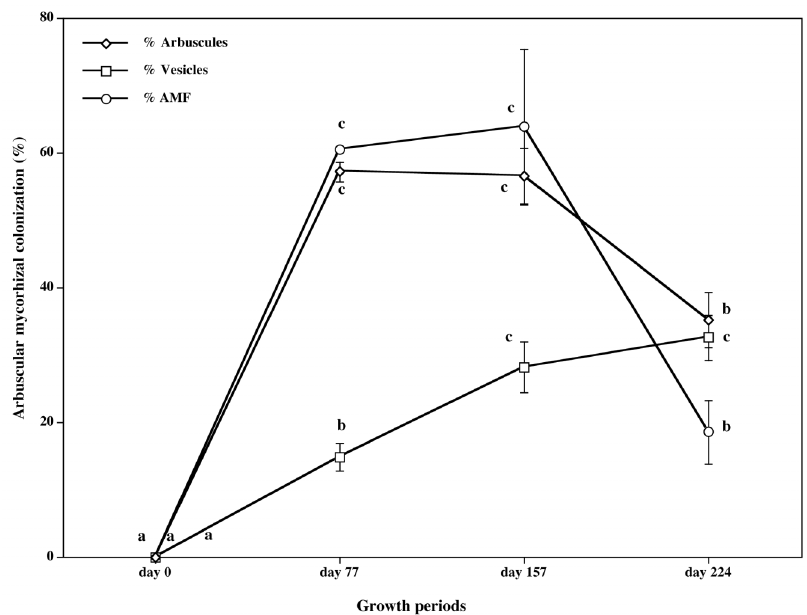
Fig. 1 . Percentage (%) root length of Agathosma betulina colonized by arbuscular mycorrhizal fungi (% arbuscular-, % vesicular-, and % hyphal colonization) belonging to the genera Acaulospora and Glomus . The differences between harvests (n = 4) were separated using a post hoc Student Newman Kuels, multiple comparison test (p £ 0.05). Statistically significant differences (p £ 0.05) between each harvest are indicated by different letters. Error bars represent mean ± SE (n =